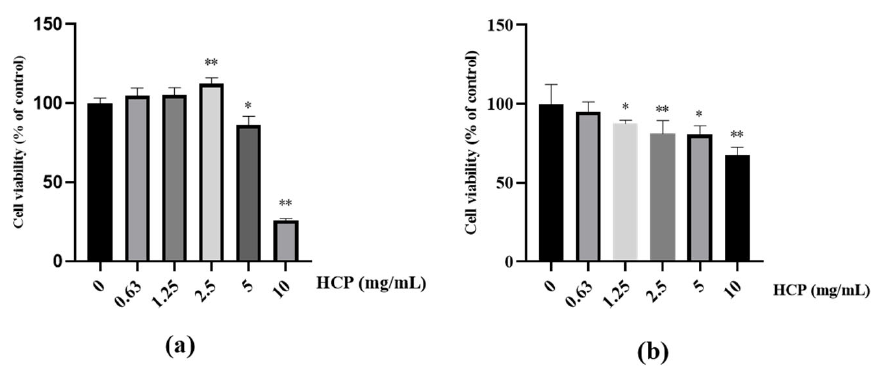
Figure 2. ( a ) Melanoma cells (MNT ‐ 1) viability in the presence of different concentrations of hydrolyzed conchiolin protein (HCP) measured by MTT assay (* p < 0.05; ** p < 0.01 vs. control. T test); ( b ) Human keratinocyte (HaCaT) viability in the presence of different concentrations of HCP measured by MTT assay (* p < 0.05; ** p < 0.01 vs. control. T test); all data are mean ± SD of at least